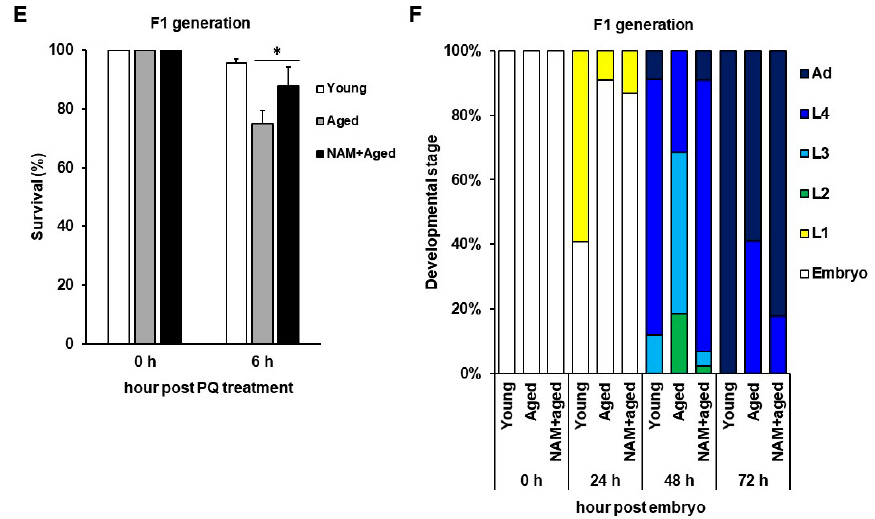
Figure 5. Motility, oxidative stress resistance, and developmental growth in offspring produced by aged oocytes are improved by maternal nicotinamide (NAM) supplementation in Caenorhabditis elegans : ( A ) The mitochondrial morphology was analyzed using SJ4103 expressing a mitochondrial-targeted GFP under the control of the muscle-specific myo-3 promoter in the F1 trans- genic animals produced by young, aged, and NAM+aged mothers (each condition, n = 40). The graph indicates the percentage of animals with muscle mitochondria classified into three categories—1) normal, 2) fused, and 3) fragmented; ( B ) The myofila- ment abnormality was visualized using the MYO-3::GFP transgene in the F1 generation of young, aged, and NAM+aged moth- ers. Representative fluorescence images of the F1 generation produced by young, aged, and NAM+aged mothers are shown (each condition, n = 40). The graph indicates the percentage of animals classified as normal or damaged muscle; ( C ) Comparison of head thrashing in the F1 generation produced by young, aged, and NAM+aged mothers (each condition, n = 30). Error bars represent standard deviation (SD). **, p < 0.01 (one-way ANOVA with Tukey’s post hoc test); ( D ) Comparison of body bending in the F1 generation of young, aged, and NAM+aged mothers (each condition, n = 30). Error bars represent SD. **, p < 0.01 (one- way ANOVA with Tukey’s post hoc test); ( E ) The percentage of survival rate in the F1 generation produced by young, aged, and NAM+aged mothers was analyzed under paraquat (100 mM)-induced oxidative stress condition (each condition, n = 30). Error bars represent SD. *, p < 0.05 (two-way ANOVA with Tukey’s post hoc test); ( F ) The developmental stage of each individ- ual in the F1 generation produced by young, aged, and NAM+aged mothers was determined based on its size and stage-specific morphological characteristics (see Materials and Methods) during development.